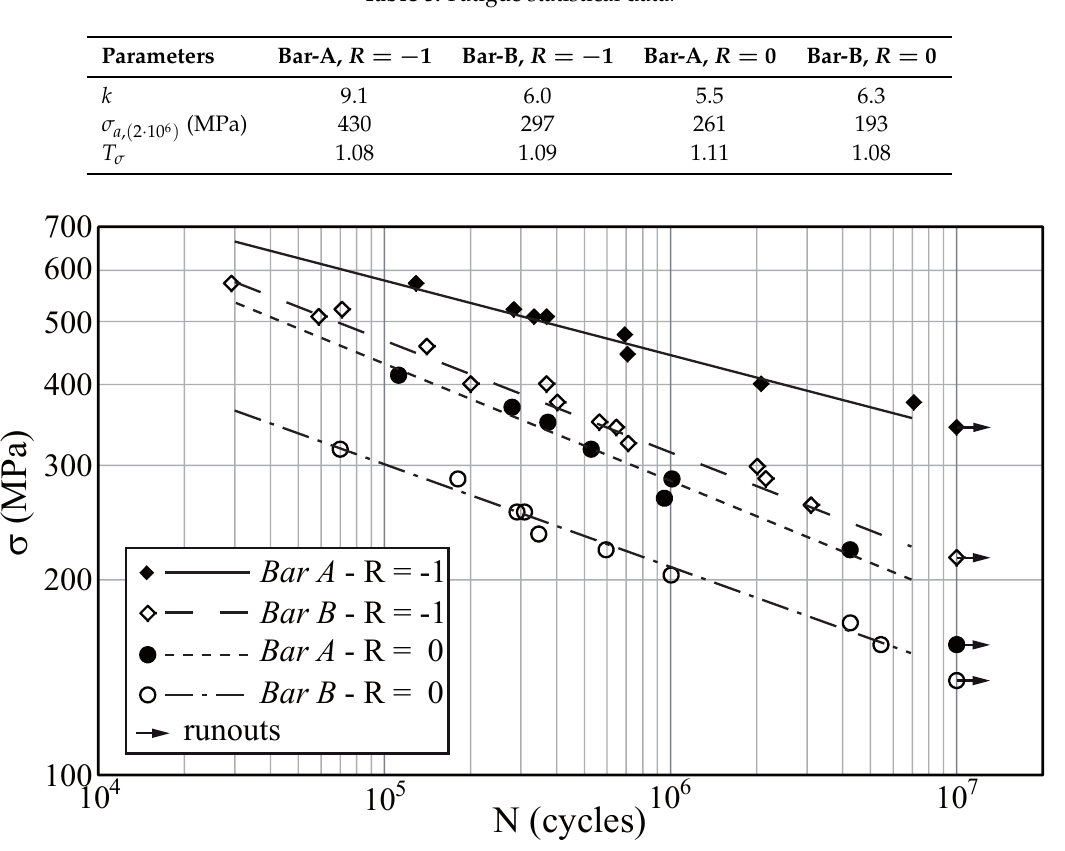
Figure 8. Fatigue test results for R = − 1 and R = − 0 with regression